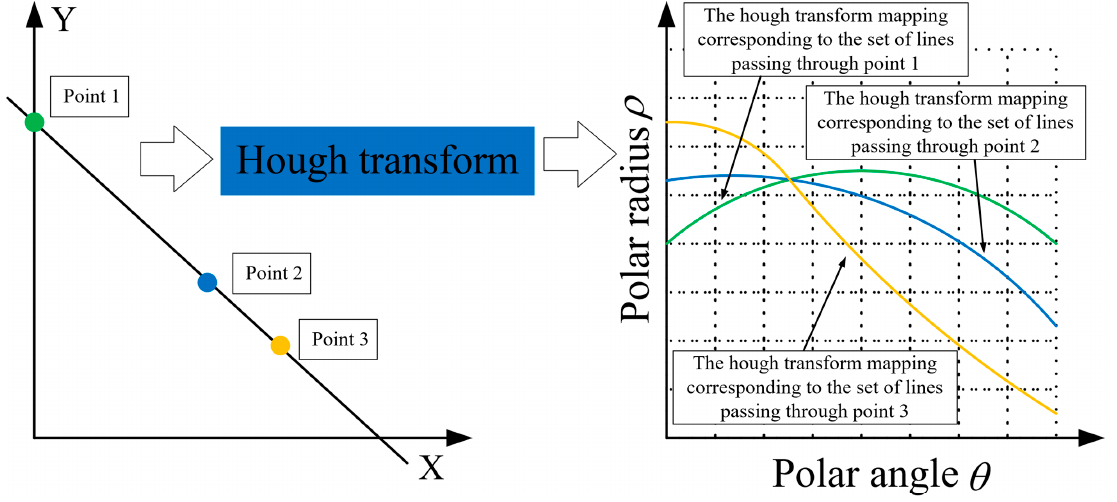
Figure 8. Principle of Hough transform in detection of straight lines.